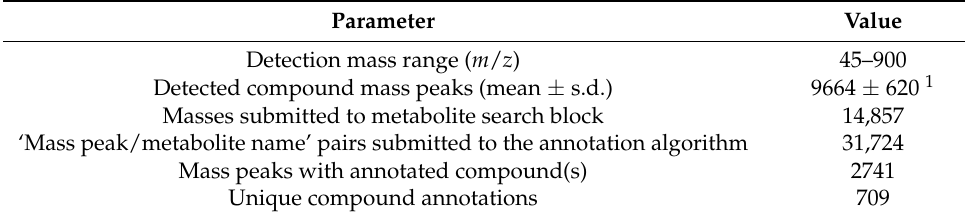
Table 1. Variables associated with this